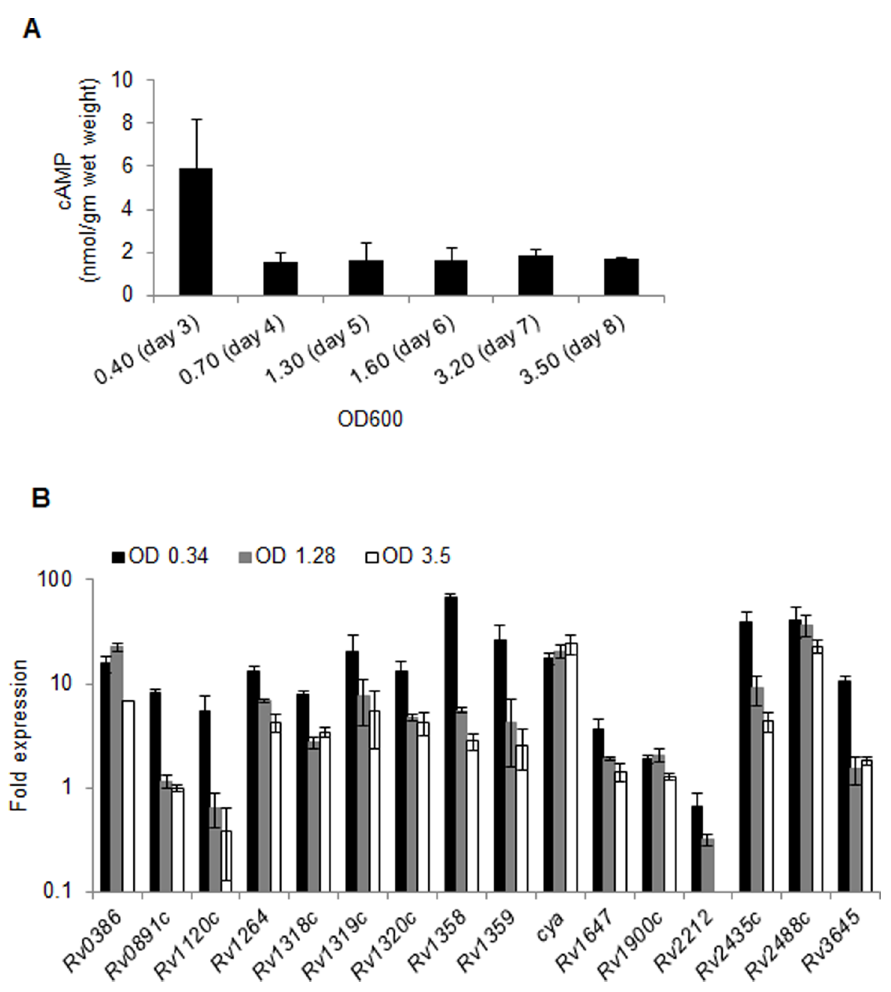
Figure 1. Kinetics of intracellular cAMP levels and expression of ACs in Mtb during invitro growth. A) Estimation of intracellular cAMP levels in Mtb. Wild-type Mtb CDC1551 was cultured in Middlebrook 7H9 broth supplemented with OADC, glycerol, and tween-80 at 37 u C with shaking and growth was monitored at regular intervals by measuring optical density of the cultures at 600 nm (OD 600 ). An aliquot of culture suspension was used at each time point up to 8 days for cAMP measurement, as described in materials and methods, and final cAMP concentration was calculated as nmol/gm wet weight. Data are the averages of two independent experiments and the mean values 6 standard deviations are shown. B) Analysis of the expression of AC-encoding genes at different time points during in vitro growth of Mtb. Total RNA was isolated from Mtb CDC1551 cultures at regular intervals as shown in the graph. Quantitative RT-PCR (qRT-PCR) was performed, and the relative expression of each gene was calculated using values of sigA transcript for normalizing the RNA amounts and day-1 expression value as a control. The graph represents an average of two independent experiments and the mean values 6 standard deviations are shown.